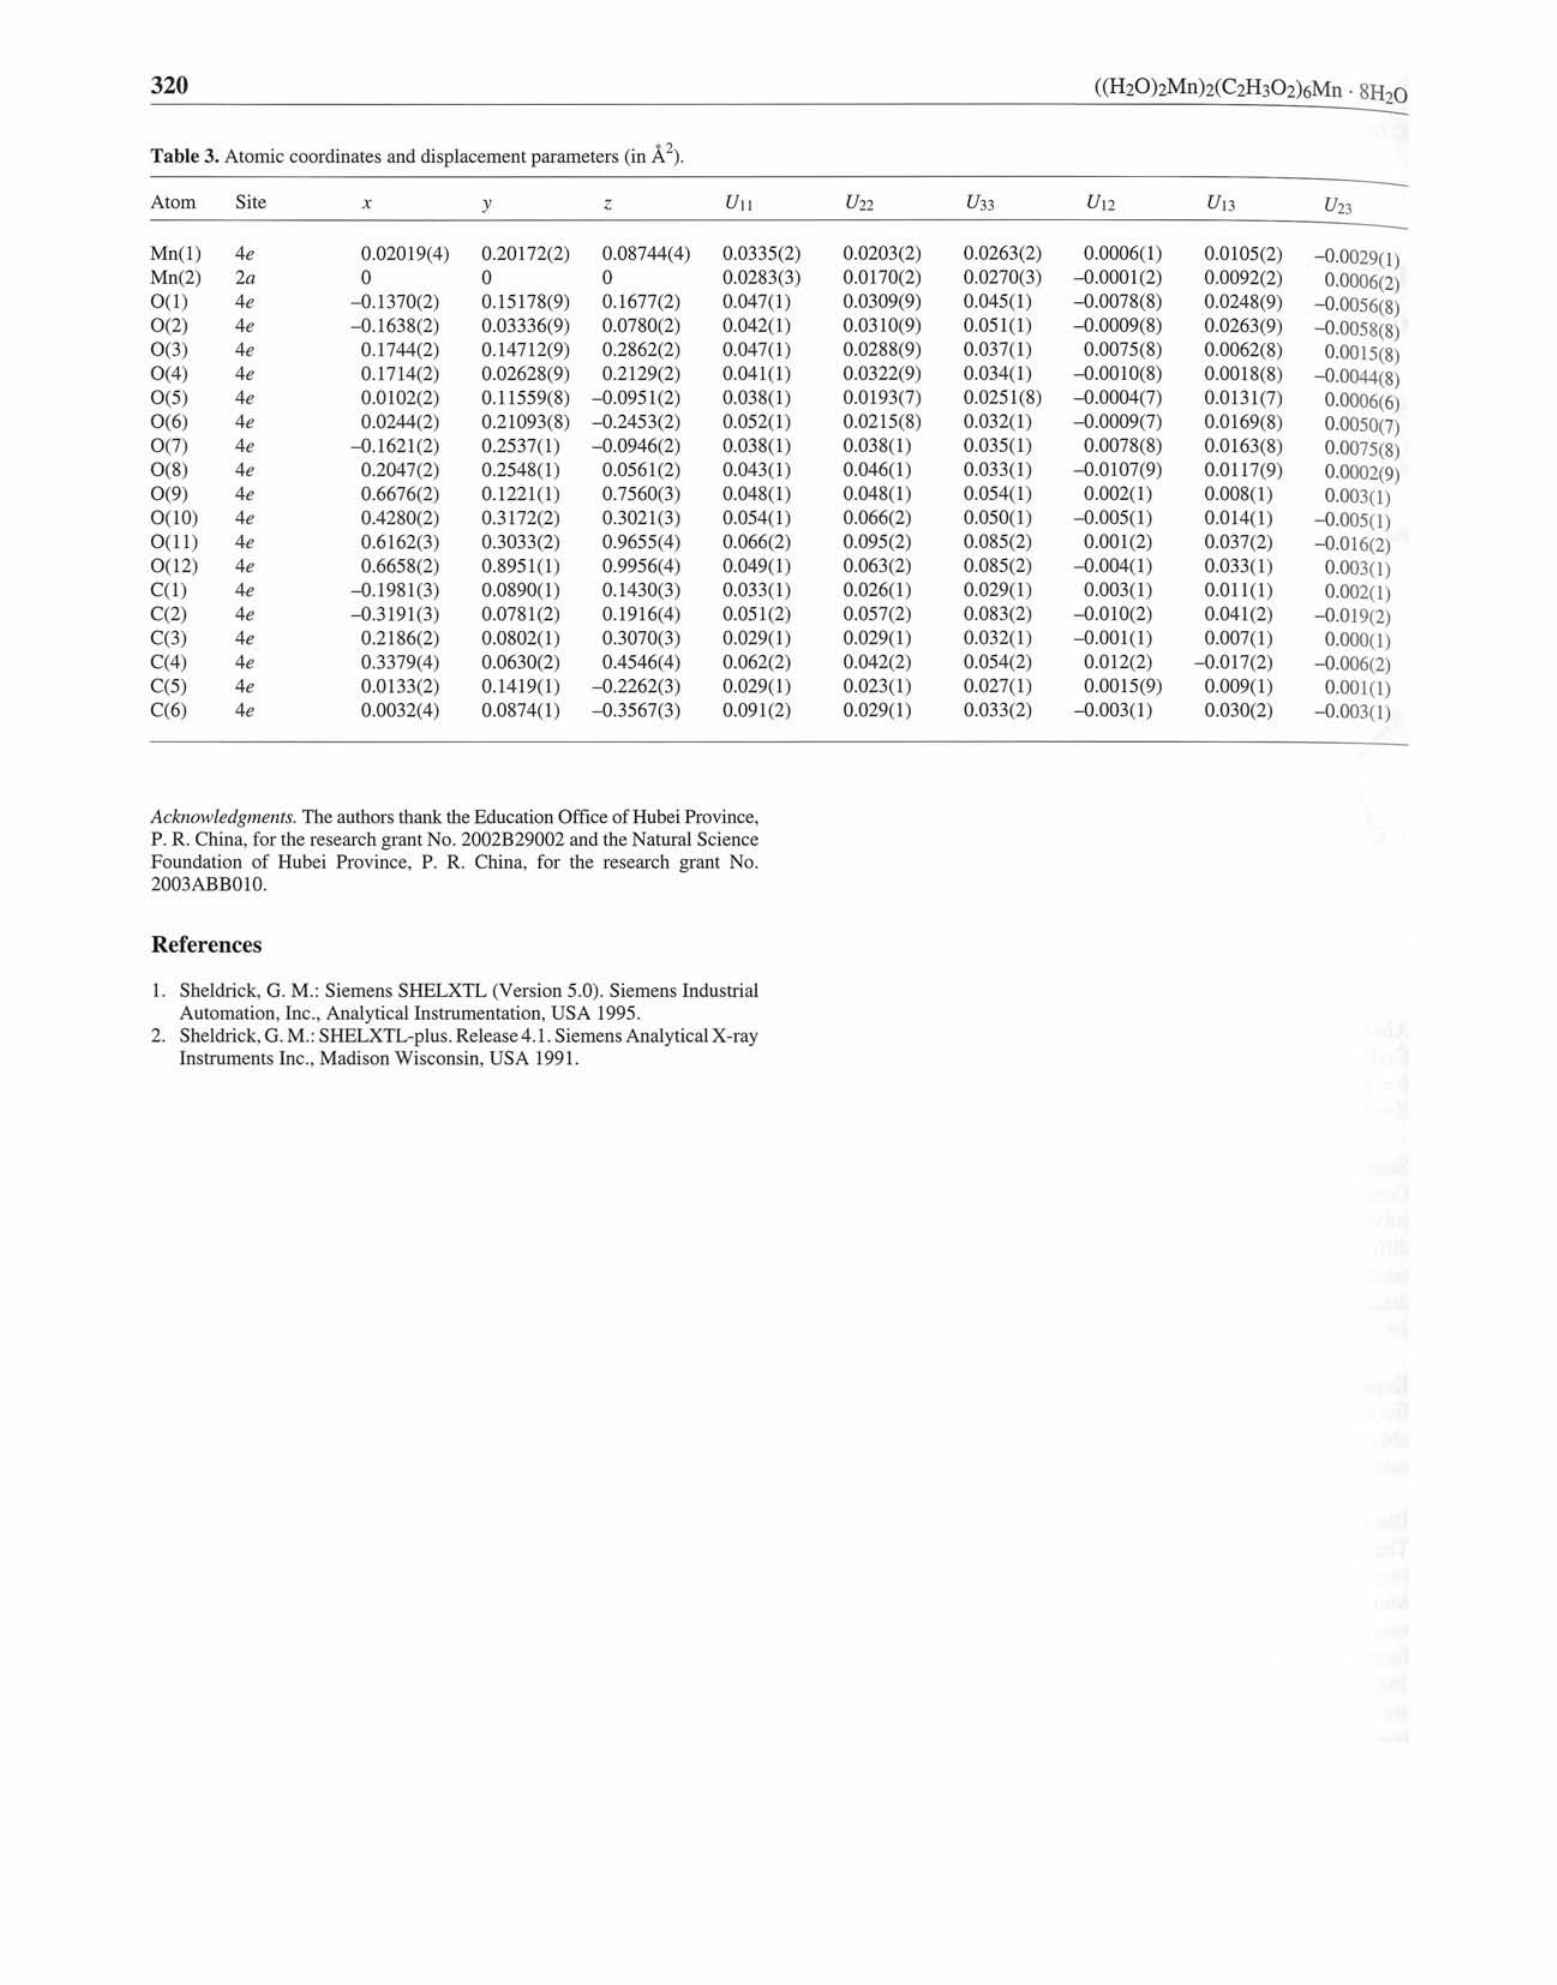
Table 3. Atomic coordinates and displacement parameters (in À 2